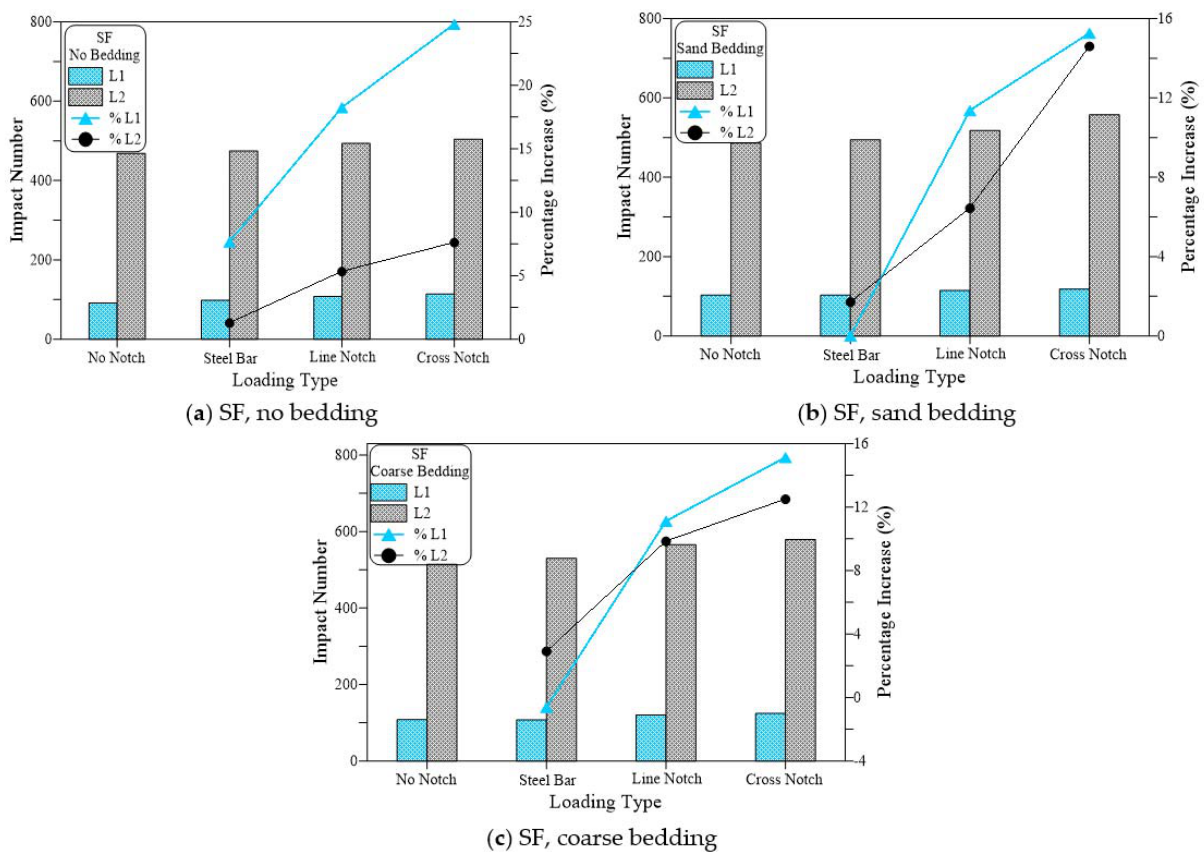
Figure 15. Loading type effect on cracking and failure impact numbers of SF specimens. ( a ) SF, no bedding, ( b ) SF, sand bedding ( c ) SF, coarse